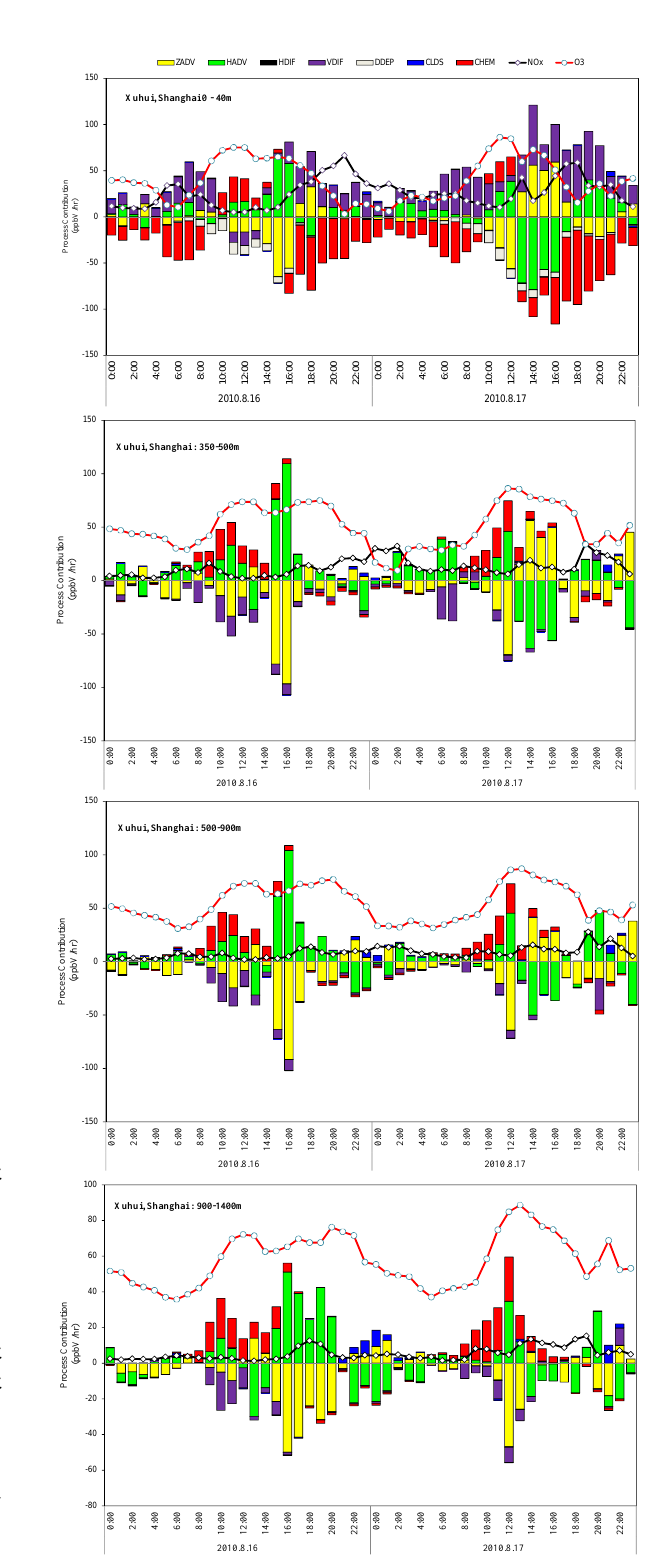
Fig.8. Atmospheric processes contribution to net O 3 density at Xuhui site during August 16--17, 2010. Fig. 8. Atmospheric processes contribution to net O 3 density at As discussed above, gas-phase chemistry in the surface layer could either increase or reduce O 3 Xuhui site during 16–17 August concentrations, depending on locations and times. Figure 9 shows the local emission inputs of NO, NO 2 and seven major VOC species including ethane (ETH), terminal olefin carbon bond (OLE), internal olefin carbon bond (IOLE), isoprene (ISOP), terpene (TERP), toluene and other monoalkyl aromatics (TOL) and xylene and other polyalkyl aromatics (XYL) at the Xuhui site. These figures show that the NO emissions in the urban Shanghai area are more significant than the VOCs emissions. Thus, in the daytime, especially during 10:00-16:00 LST, when both the precursor emissions and the solar radiation are high, the gas-phase chemistry plays a positive effect on O 3 production, while after sunset, the high emissions of NO quickly titrate O 3 , causing the destruction of O 3 .